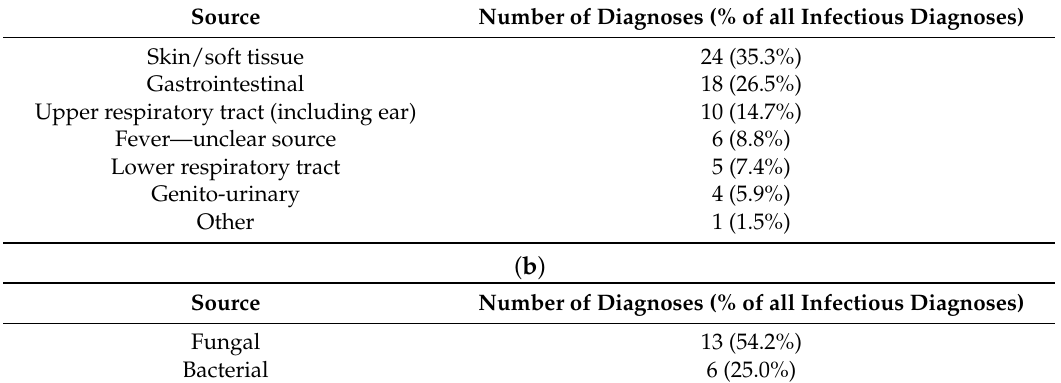
Table 1. ( a ) Breakdown of infections by system affected; ( b ) Types of skin infection.